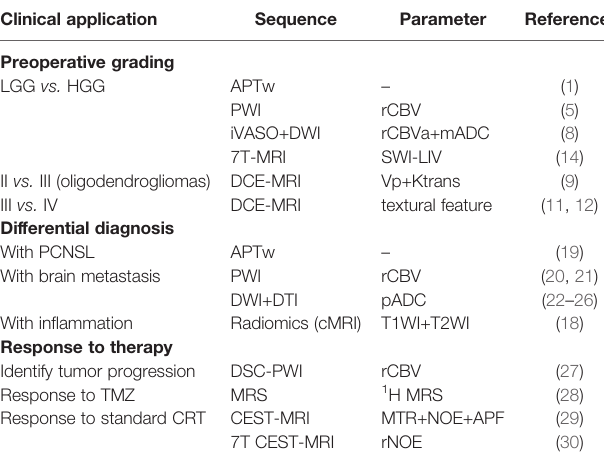
TABLE 1 | MR sequence and parameter in glioma